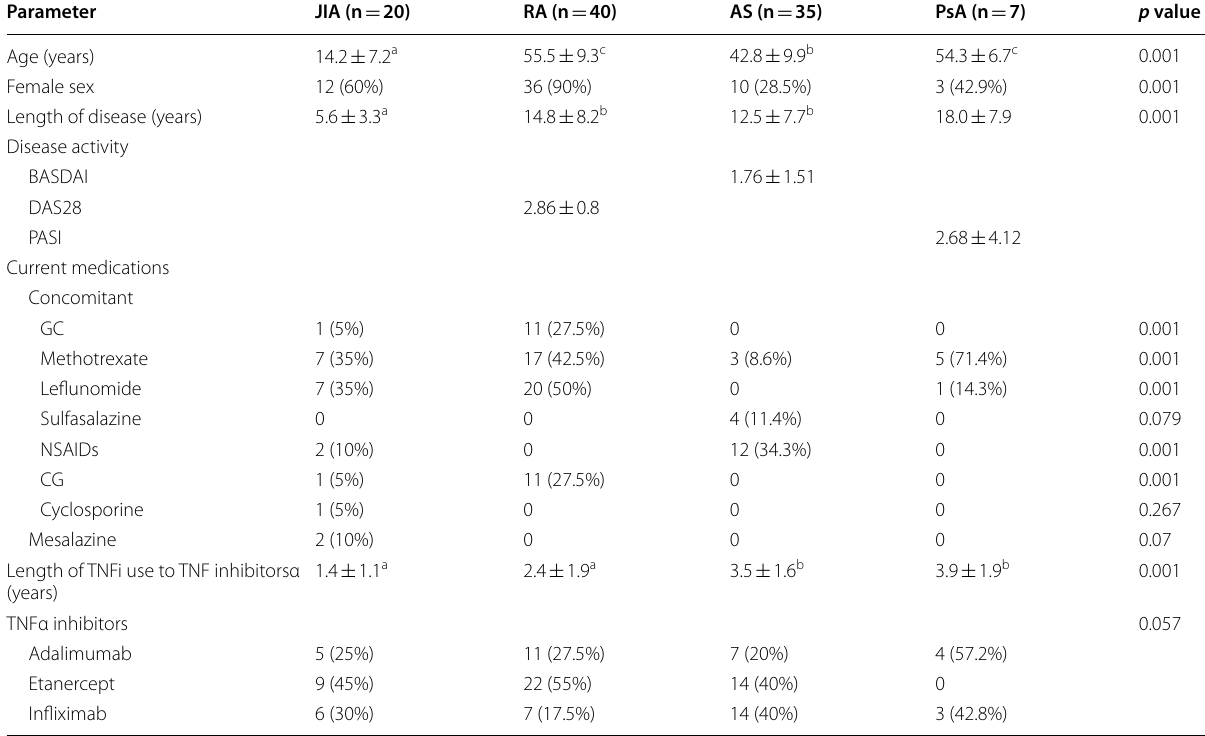
Student’s t -test, ANOVA; JIA, juvenile idiopathic arthritis; RA, rheumatoid arthritis; AS, ankylosing spondylitis; PsA, psoriatic arthritis; DAS-28, Disease Activity Score; BASDAI, Bath Ankylosing Spondylitis Disease Activity Index; PASI, Psoriasis Area Severity Index; NSAIDs, non-steroidal anti-inflammatory drugs; TNFi, TNF inhibitors; GC, glucocorticosteroids; (a) and (b) had different means according to Duncan’s multiple comparison test (age and period of exposure) or (c) Dunnet’s test at an overall level of significance of